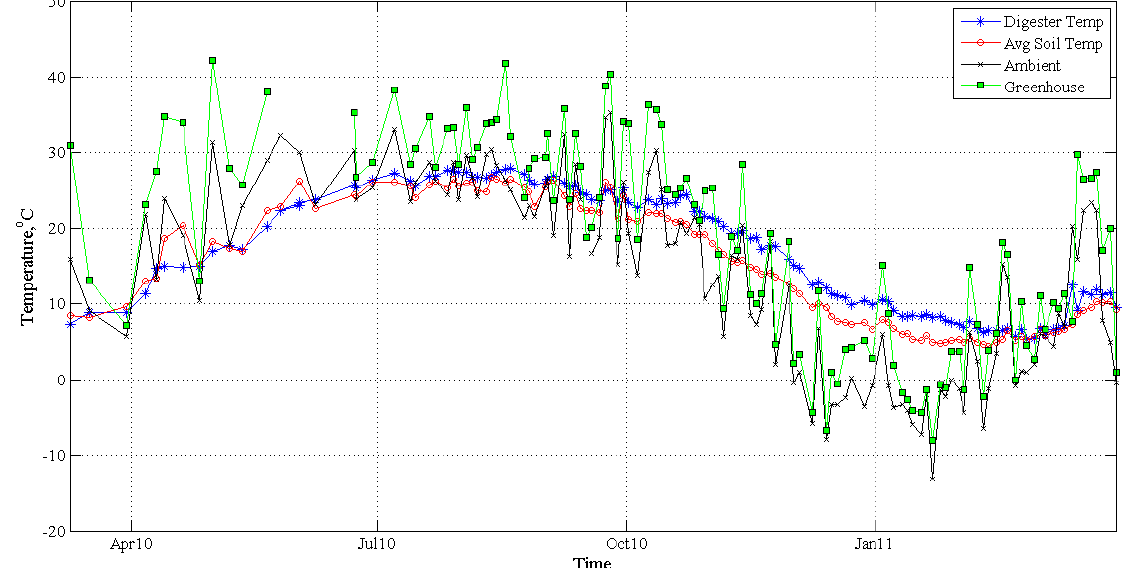
Figure 1. Temperature data for the digester, average soil, ambient and greenhouse from 8 March 2010–31 March